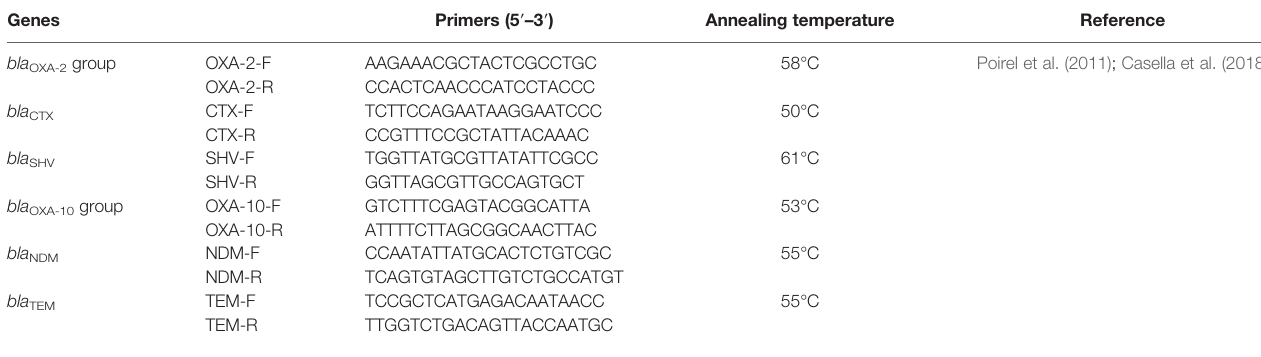
TABLE 1 | Primers used for detection and sequencing of target genes in Escherichia coli isolates. Genes Primers (5 ′ – 3 ′